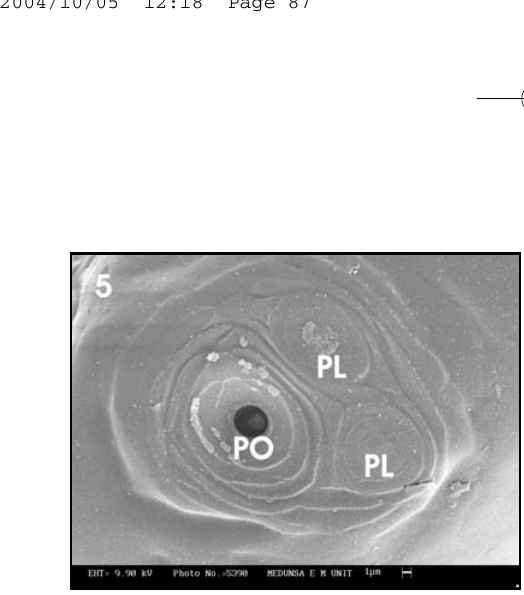
Fig. 8. Each leg had a large claw which gradually acuminated towards the most distal end.